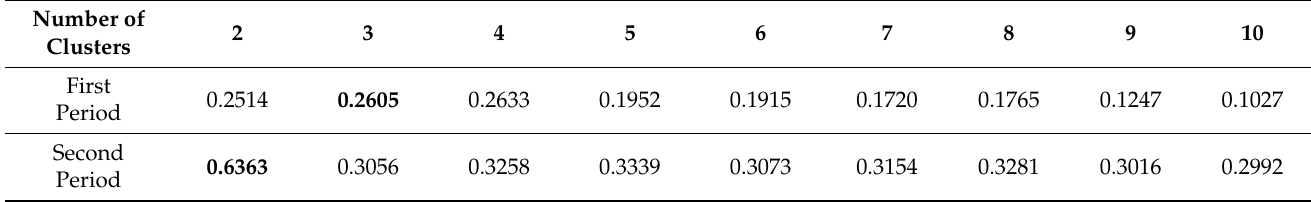
Table 2. Silhouette width values in the clusters tested in this